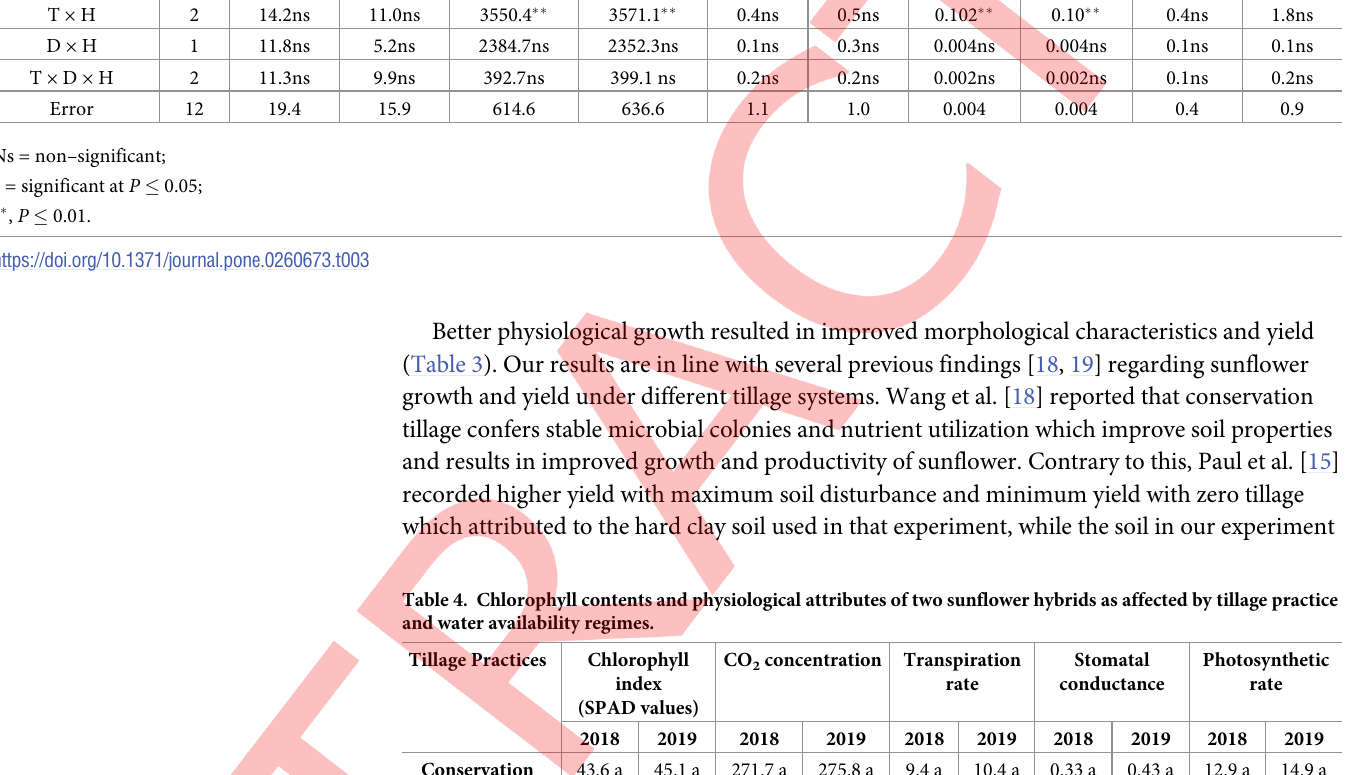
Main plot error